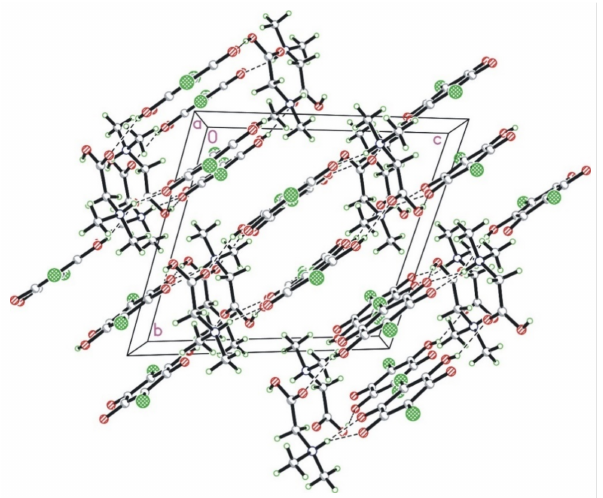
Figure 2. The crystal packing of N,N-dimethylglycine–chloranilic acid 1:1 shown in the a -direction.